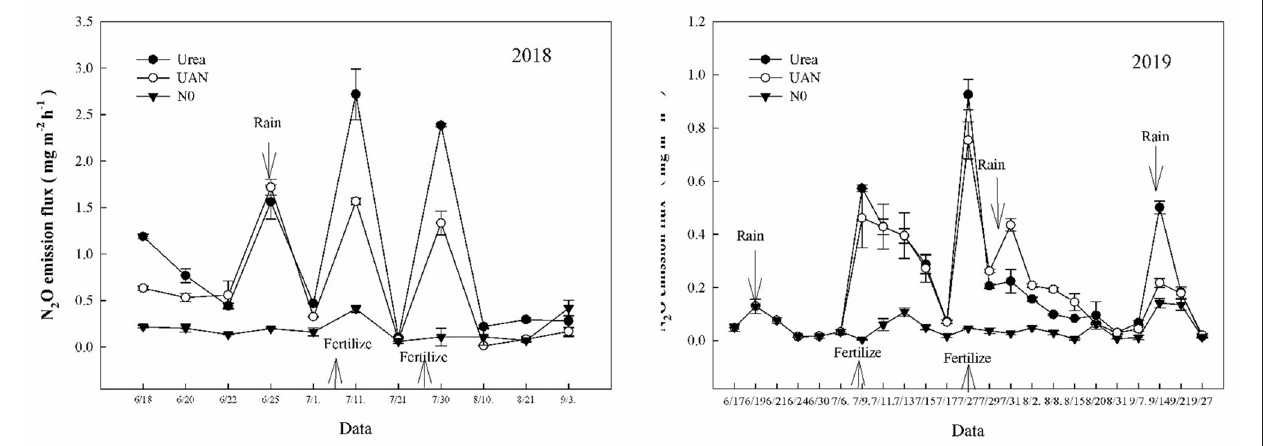
FIGURE 2 | Effects of nitrogen fertilizer types on soil N 2 O emission.